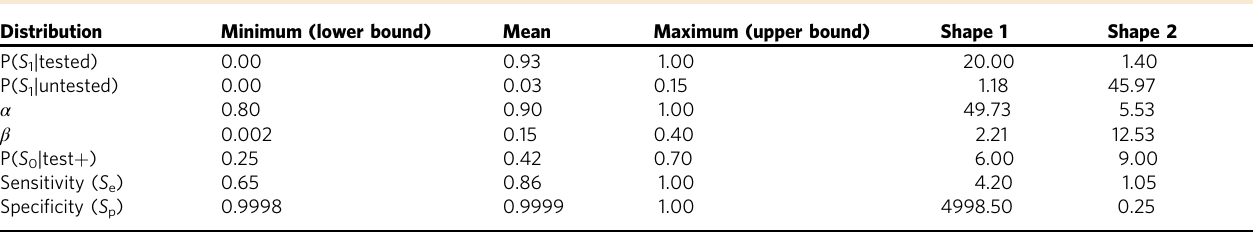
Table 1 Prior distributions for probabilistic bias